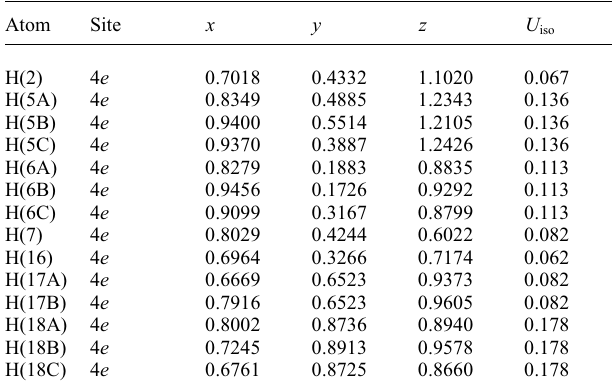
Table 2. Atomic coordinates and displacement parameters (in Å 2 ) .